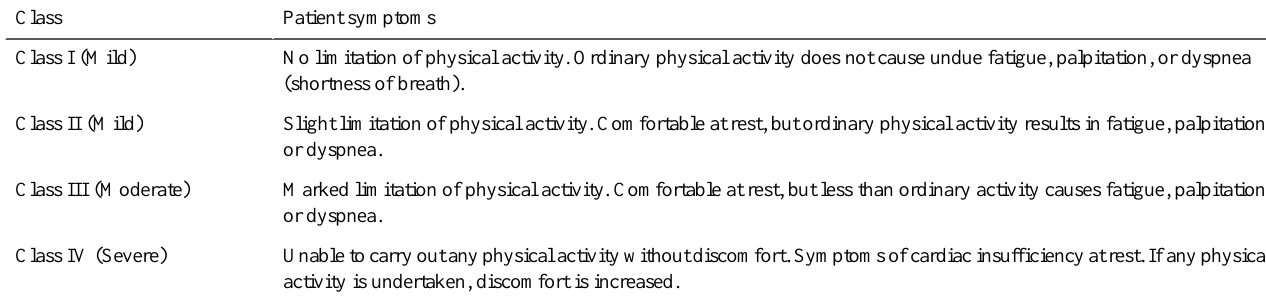
Table 6. NYHA: New York Heart Association classification for heart